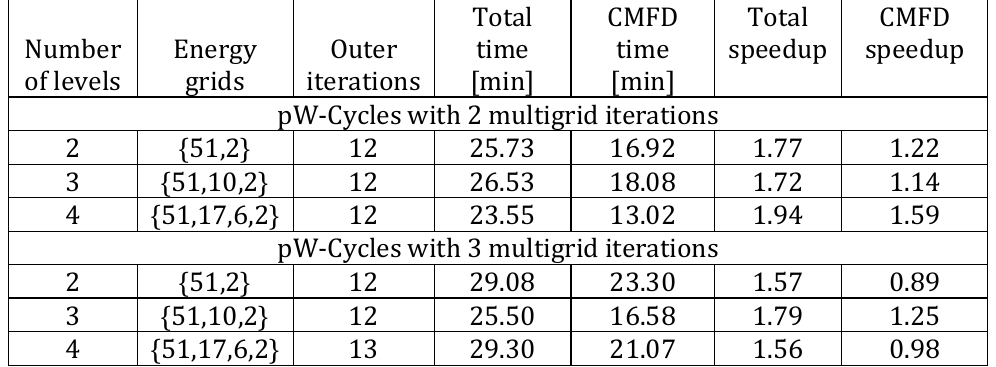
Table IV. Problem 5 MLE CMFD with partial W-Cycles